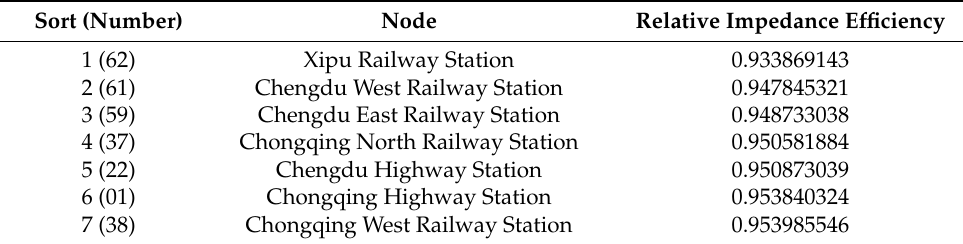
Table 1. Nodes that have a significant impact on network